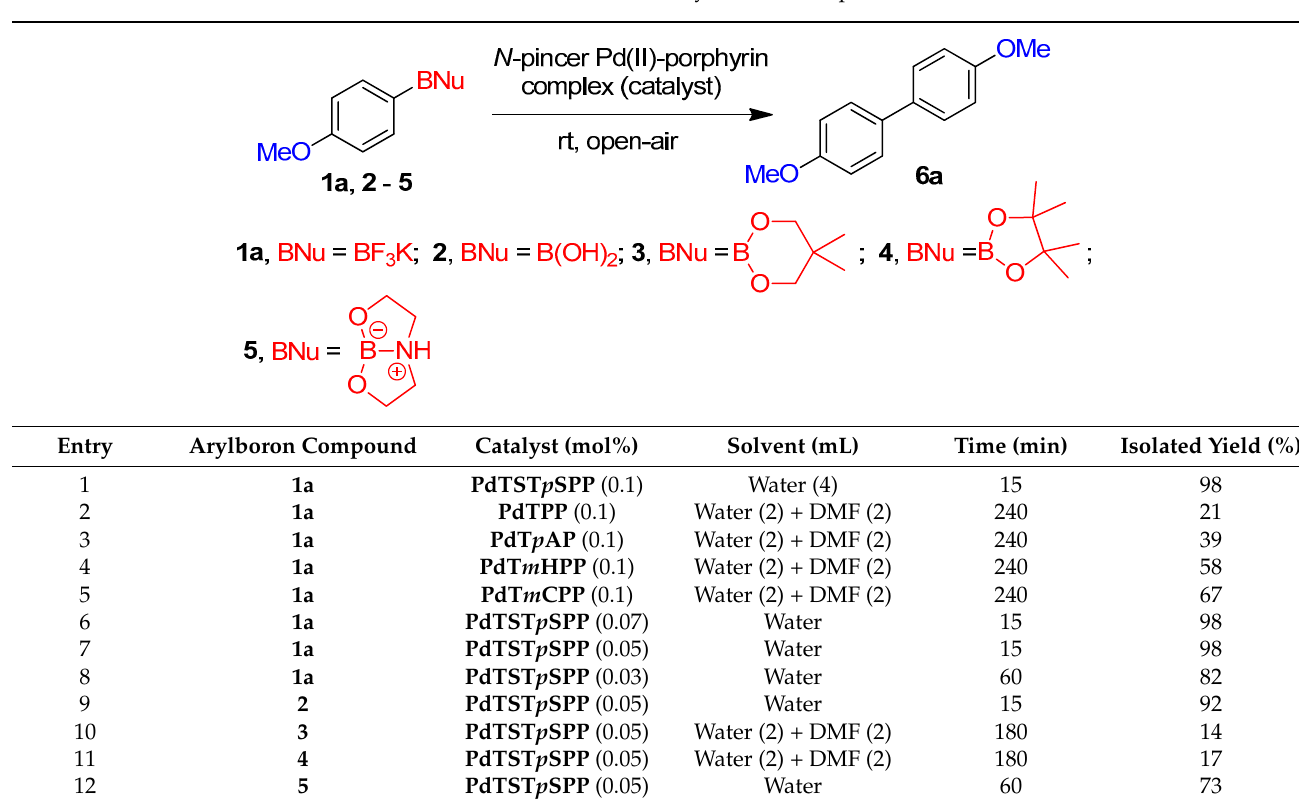
Table 1. Search for the catalyst and nucleophile 1 .